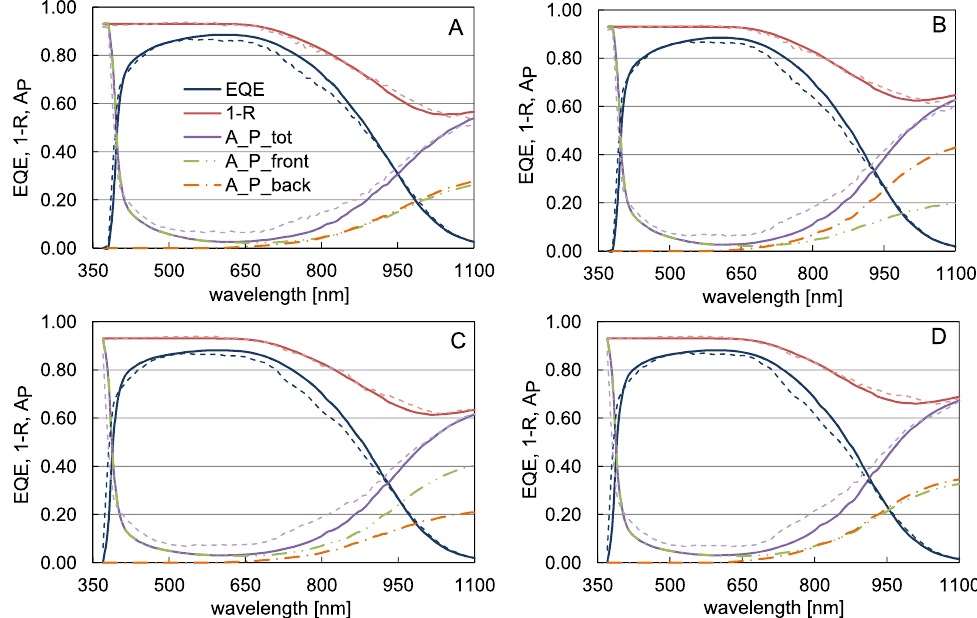
Fig. 5. Simulated (solid) and measured (dashed) EQE, total absorptance (1 − R ) and front, back and total A P curves simulated from experimental absorption data for the micromorph devices presented in Figure